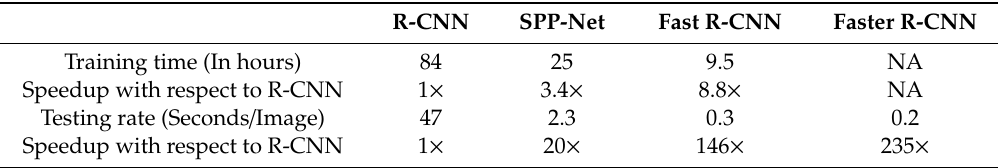
and improvements of each algorithm compared to